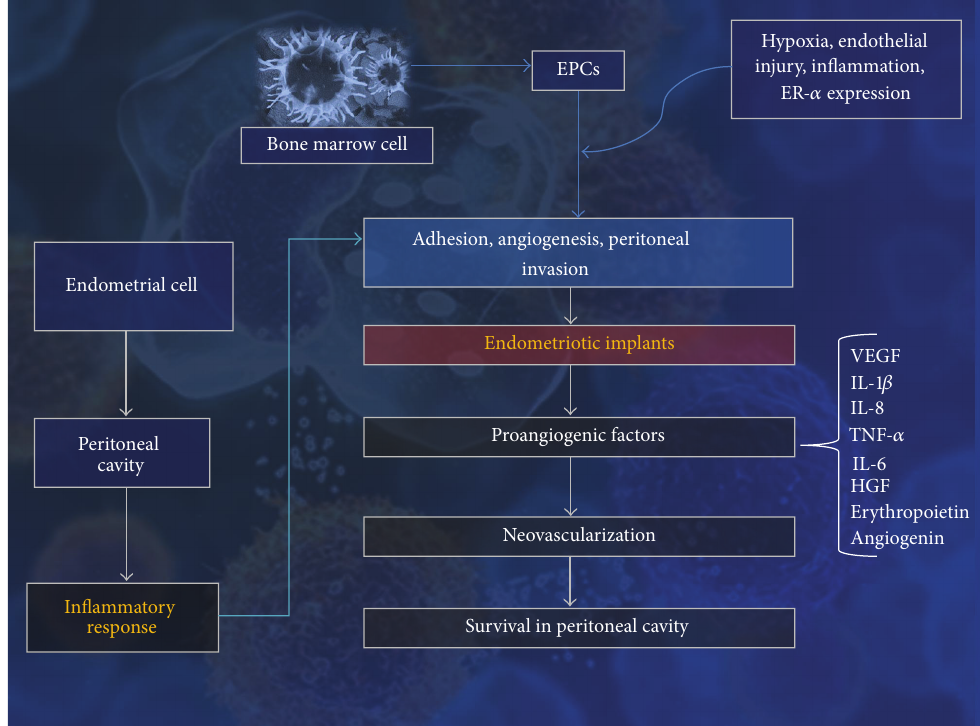
Figure 1: Angiogenesis in the pathogenesis of endometriosis. EPCs, endothelial progenitor cells; VEGF, vascular endothelial growth factor; IL, interleukin; TNF, tumor necrosis factor; HGF, hepatocyte growth